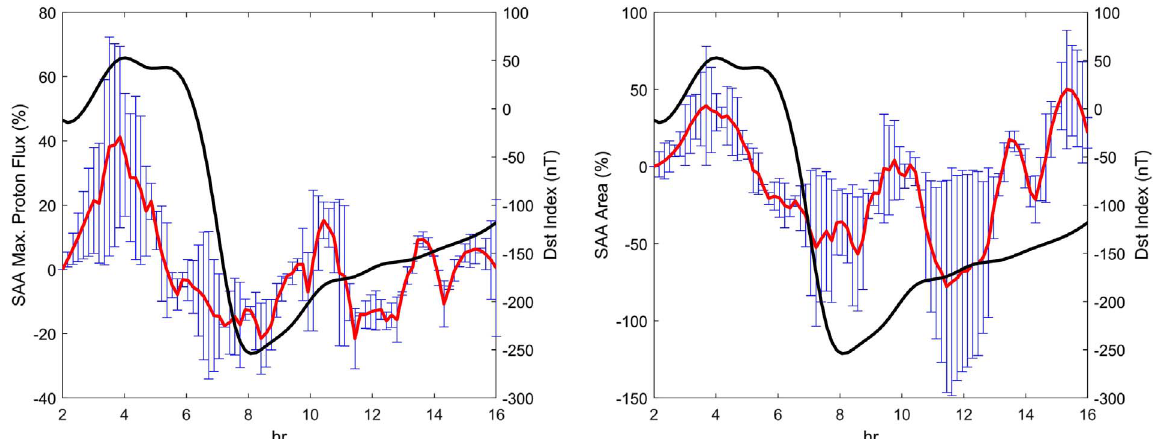
Fig. 9. The error bar shows the counting statistics of the SAA maximum proton fl ux and the associated area with respect to the beginning of the geomagnetic storm at altitude 800 km for different initial particle